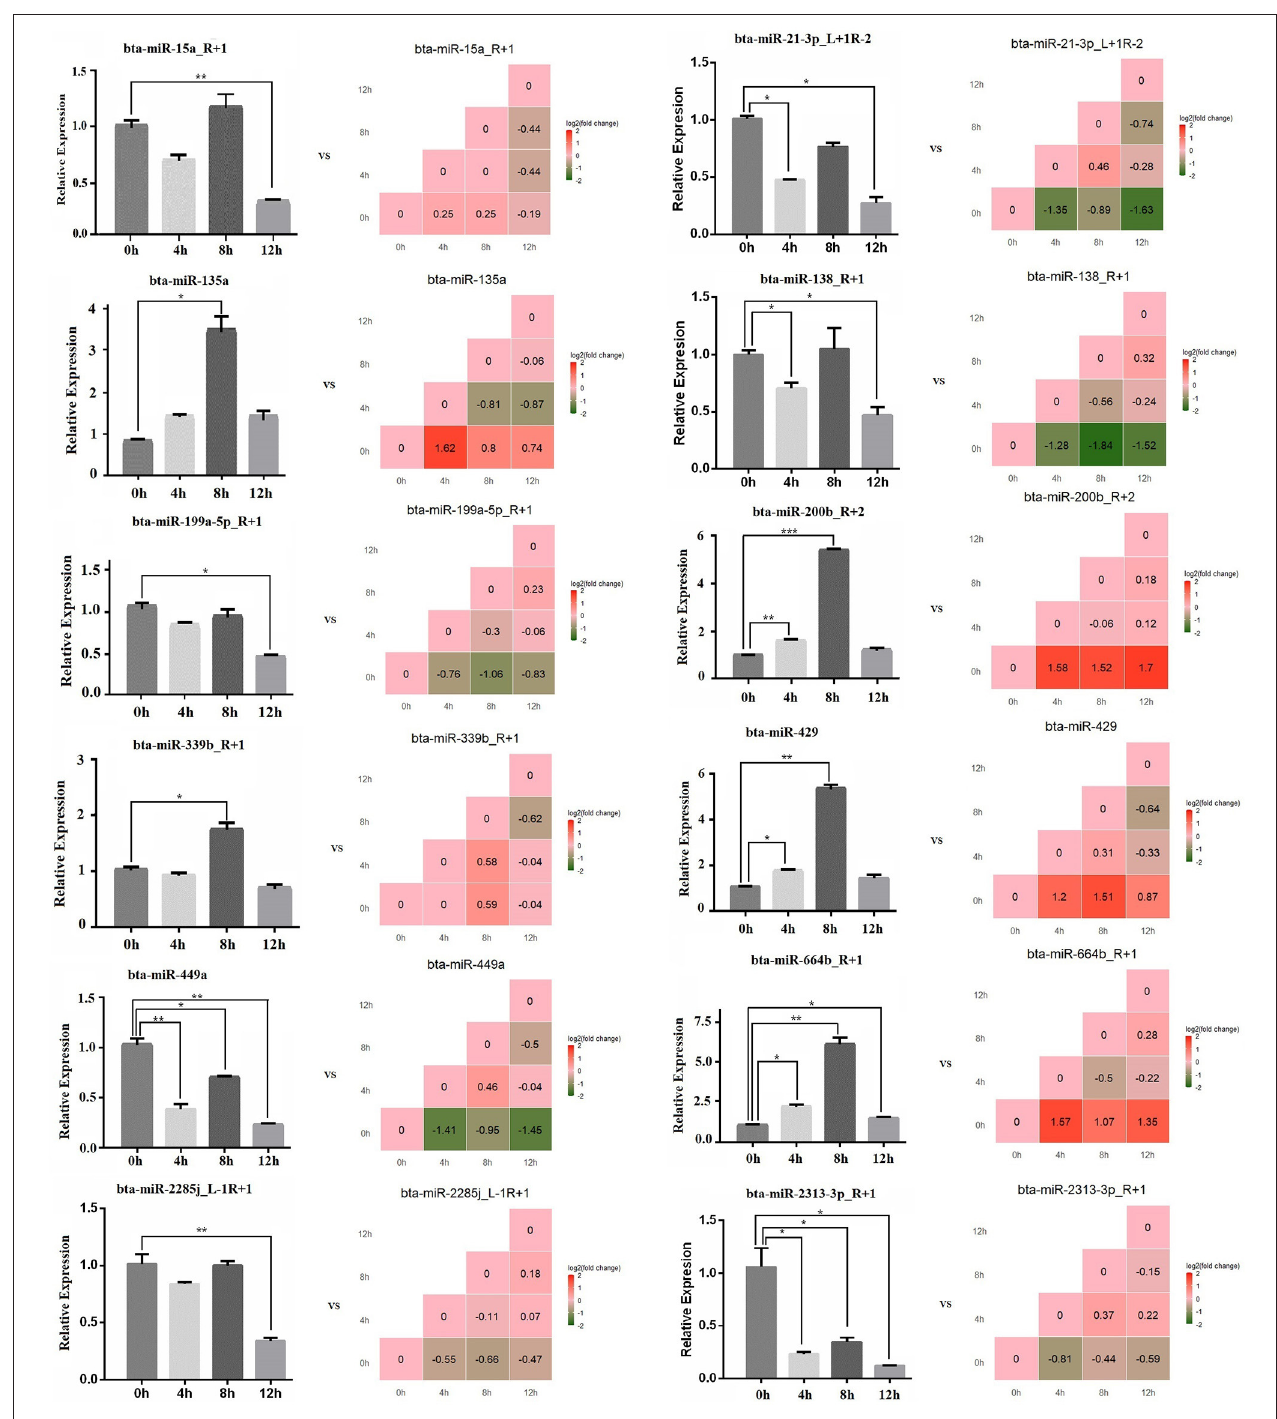
FIGURE 7 | The relative expression level of microRNA by qPCR. The bar graph is the qPCR result, and the stair graph is the sequencing result; 0, 4, 8, and 12h represent the LPS-induced 0, 4, 8, and 12h bMECs; “*” represents P ≤ 0.05; “**” represents P ≤ 0.01; “***” represents P ≤ 0.001.